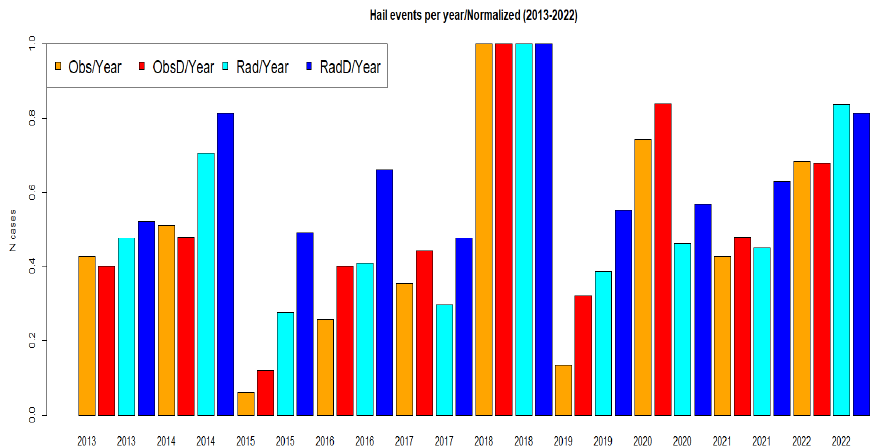
Figure 9. Normalized evolution (respect to the maximum) of the number of hail events and hail days (a hail day can contain more than one event) from the perspective of the ground observations (orange events and red days) and the radar (cyan events and blue days), for the period 2013–2022.